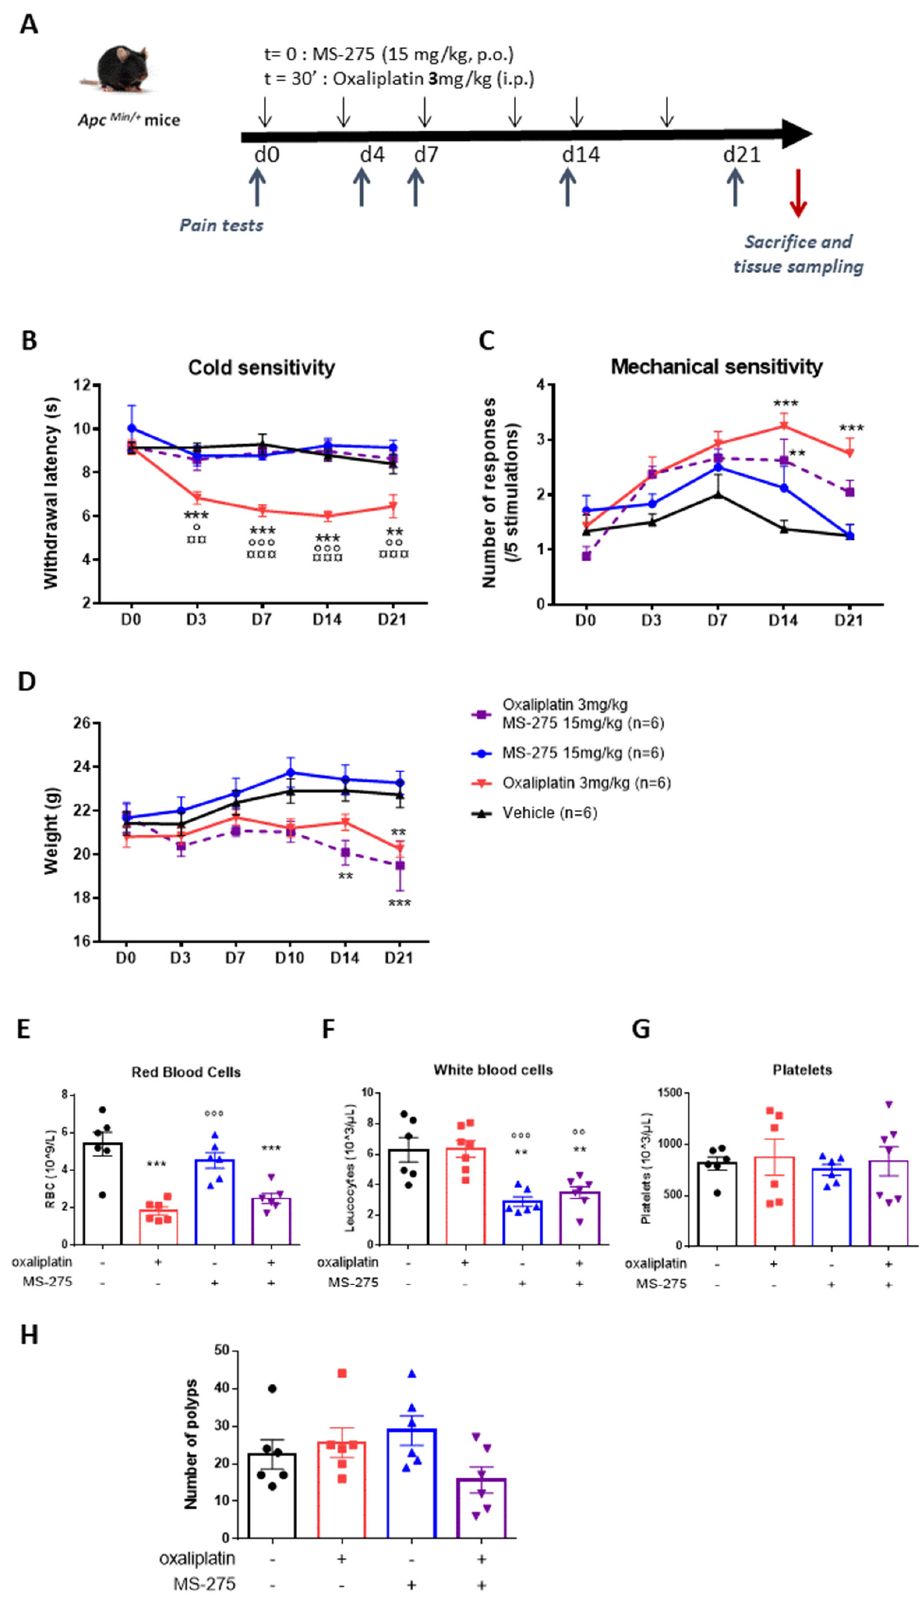
Figure 3. MS-275 prevents oxaliplatin-induced chronic neuropathic pain in APC Min/+ mice. ( A ) Ex- perimental design: APC Min/+ mice received oxaliplatin (3 mg/kg, i.p.) or vehicle (Glucose 5%) twice a week for 3 weeks. MS-275 (15 mg/kg, p.o.) was administered half an hour before each